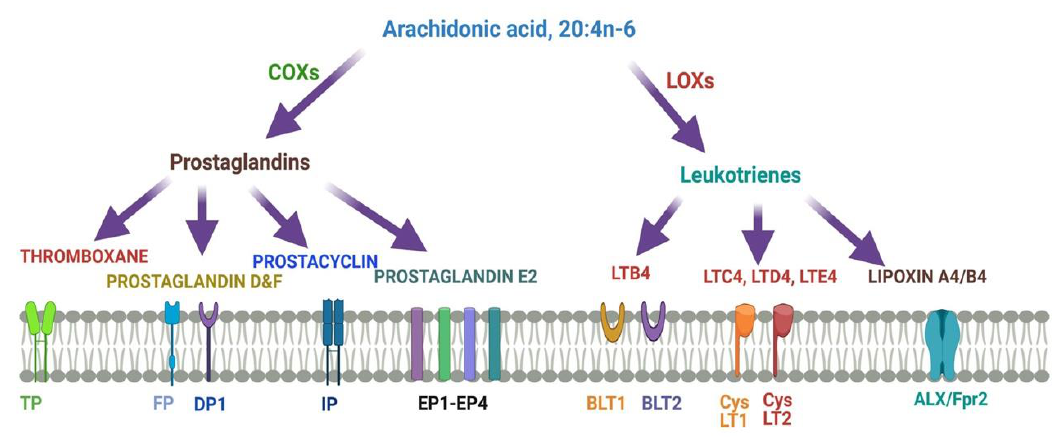
Figure 4. Metabolites of ARA and their receptors.